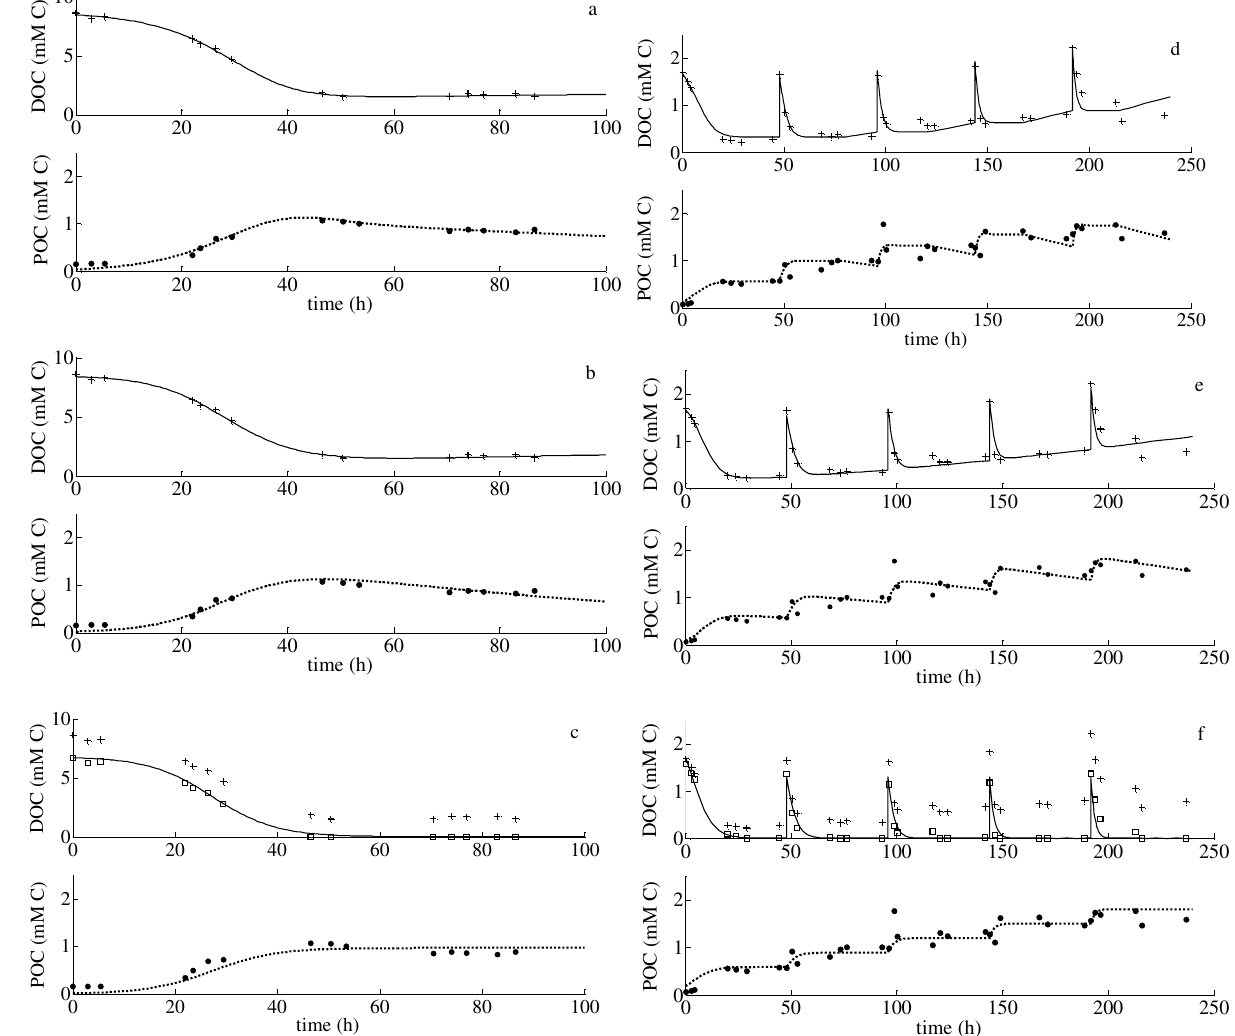
Fig. 4. Simulations of DOC (solid lines, mMC) and POC (dotted lines, mMC) concentrations for (a) the DEB, (b) Marr-Pirt and (c) Monod models for experiment SA and for (d) the DEB, (e) Marr-Pirt and (f) Monod models for experiment P. Model simulations are compared to experimental measurements of DOC (+) and POC ( (cid:13) ). Parameters of each model and for each experiment are provided in Tables 2 and 3. The Monod model was calibrated on and compared to modified DOC data to deal only with the labile part of DOC. This modified data set is represented by squares in panels c and